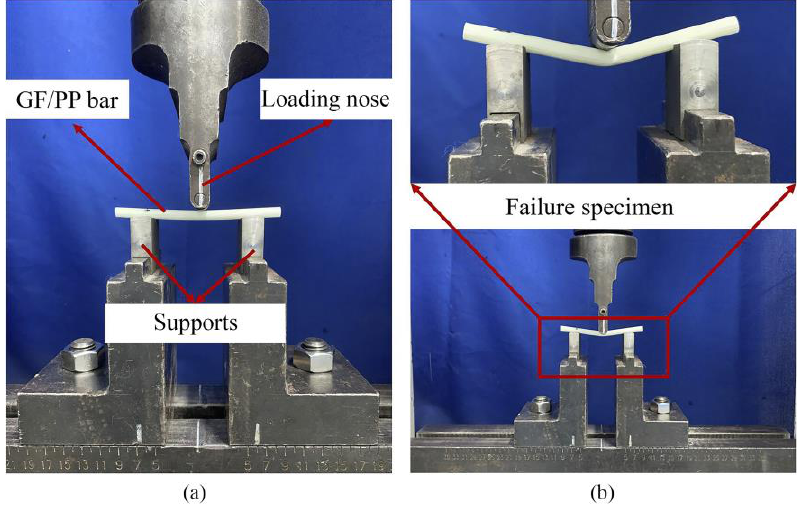
Figure 10. Test setup for tension testing of pultruded thermoplastic Ø 6mm GF/PP bars based on inhouse made PCTs: ( a ) anchorage design and assembly; ( b ) pre-tightening anchor; ( c ) anchored specimen; ( d ) tensile testing.